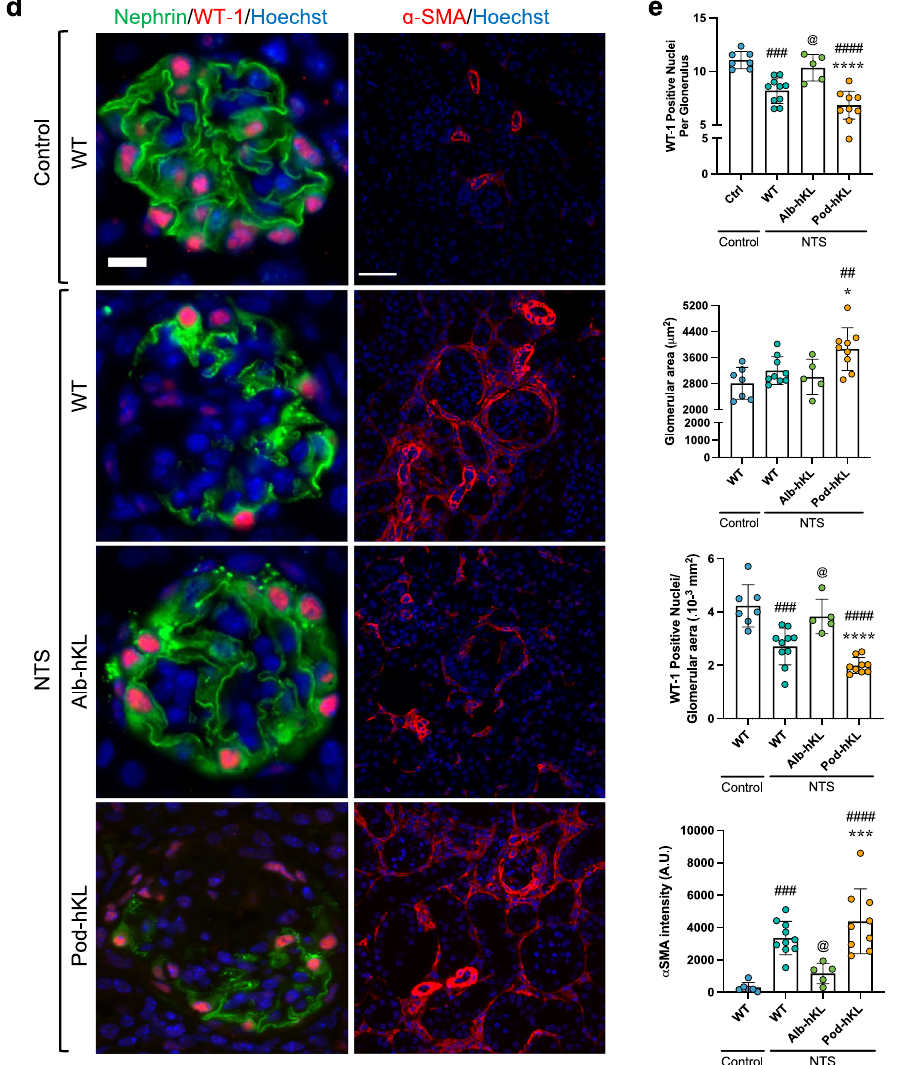
Fig. 4 Hepatocyte-speci fi c overexpression of Klotho ameliorates renal injury and proteinuria in a mouse model of NTS-induced glomerulonephritis. a Left panel: Urinary albumin/creatinine ratio (U-ACR) in WT, Alb-hKL, and Pod-hKL, 0, 1, 3, and 7 days after injection of NTS. $$$$ p < 0.0001 vs. Pod-hKL and @@@@ p < 0.0001 vs. WT. Right panel: Blood urea nitrogen in the different groups without injury (control mice) or 7 days after injection of NTS (NTS mice). #### p < 0.0001 vs. WT-control; @ p < 0.05 vs. WT-NTS. b Representative images of PAS (left panels) and TEM (right panels) of kidney cortex from WT-control and WT, Alb-hKL, Pod-hKL 7 days after NTS injection. c Percentage of affected and crescentic glomeruli were quanti fi ed from 30 randomly selected glomeruli in the corresponding PAS staining. Tubular casts were assessed over the whole cross-section giving a score between 0, no cast to 5, >80% of the tubules are affected ( n = 11 WT-control; n = 10 WT-NTS; n = 5 Alb-hKL-NTS; n = 11 Pod-hKL-NTS). Quanti fi cation of mean